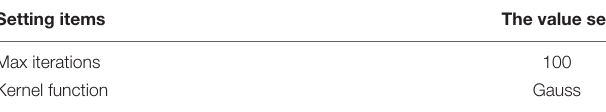
TABLE 2 | Parameters and functions of RVM. Setting items The value set Max iterations 100 Kernel function Gauss